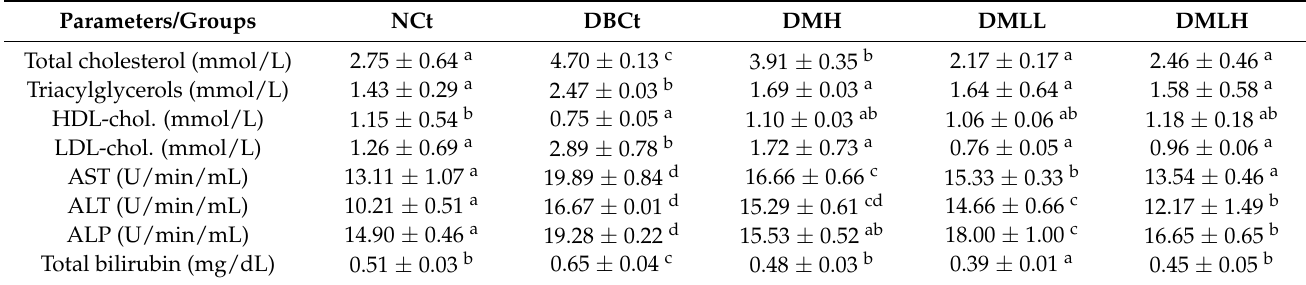
Table 1. Serum lipid profile and liver function enzymes in different groups of animals at the end of the experimental period.